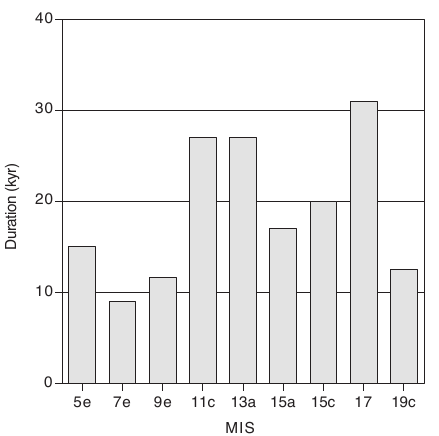
Fig. 8. Estimates of the duration of interglacials during the past 800kyr.